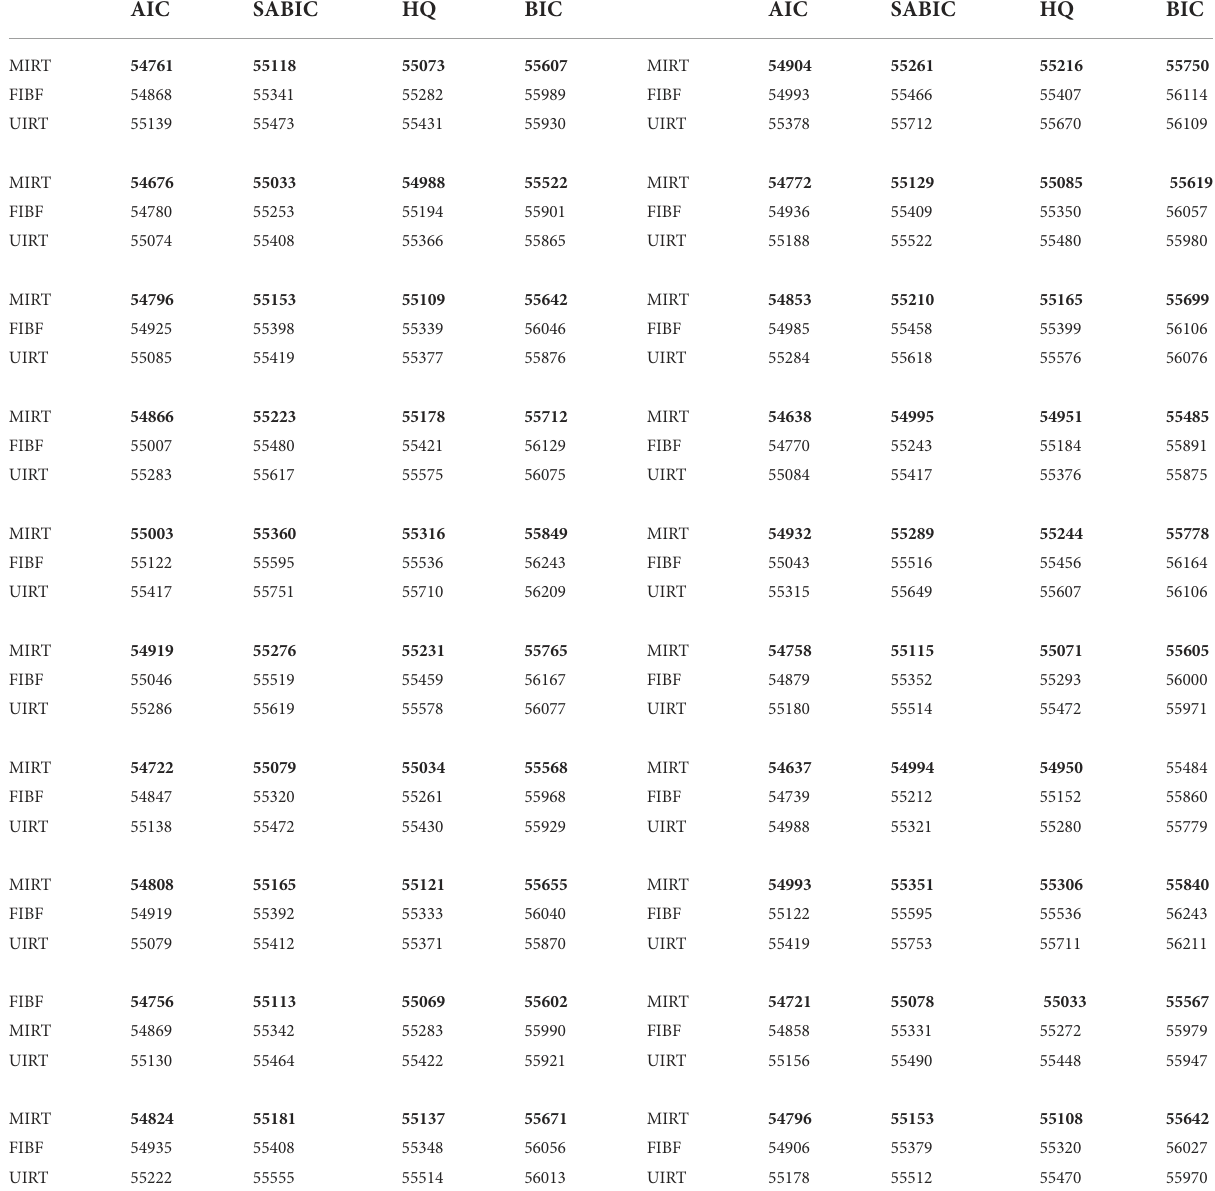
TABLE 3 Four model selection indices (AIC, SABIC, HQ, and BIC) of the three competing models (FIBF, MIRT, and UIRT) under the condition that the generating model is between-item